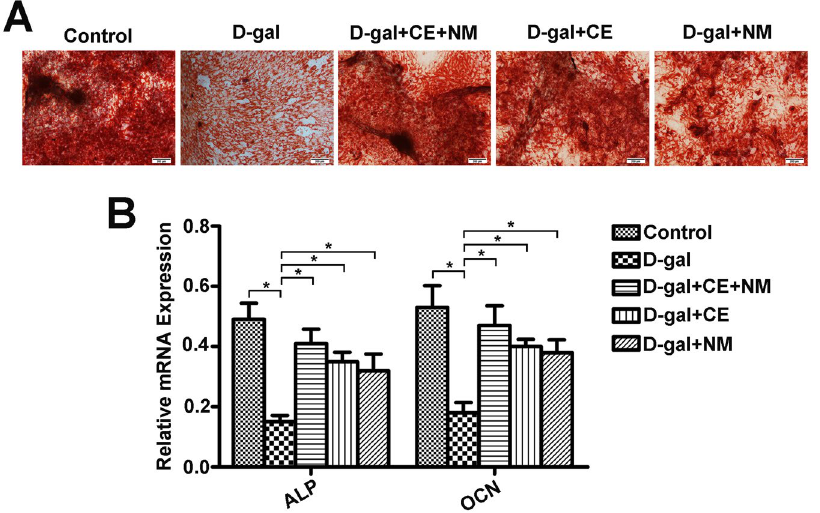
Figure 3. CE and NM supplement mediate the differentiation of BMSCs into osteoblasts in aging rats. ( A ) Alizarine Red staining of aged BMSCs treated with CE and NM after 14 days induction in osteogenic medium was shown. The expression of osteogenic specific genes including ALP and OCN were analyzed by qRT-PCR. The relative expression of each target gene to GAPDH was calculated ( * P < 0.05). Values were mean ± SD of three independent experiments.